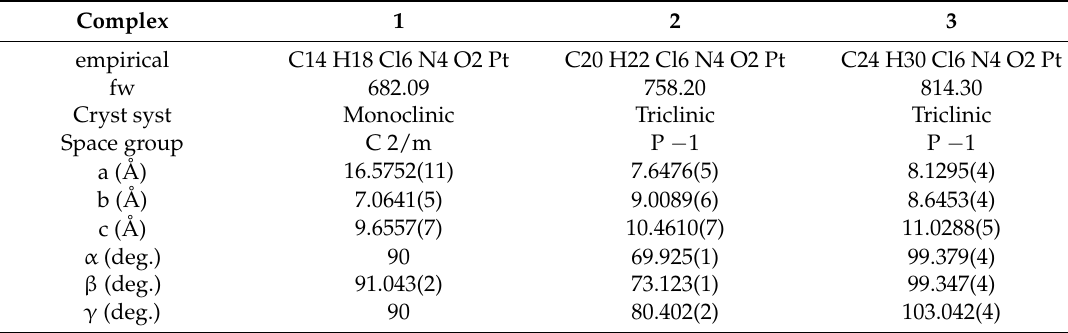
Table 1. Crystallographic data and refinement parameters for complexes 1 – 3